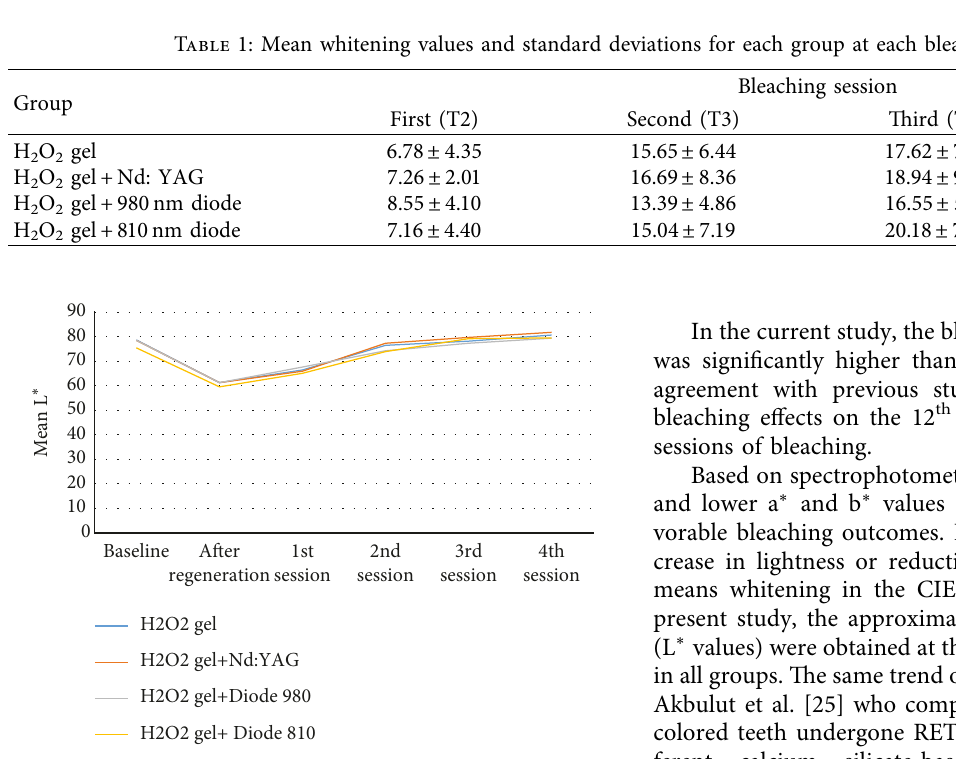
Figure 2: L mean changing trends in each group during the ∗